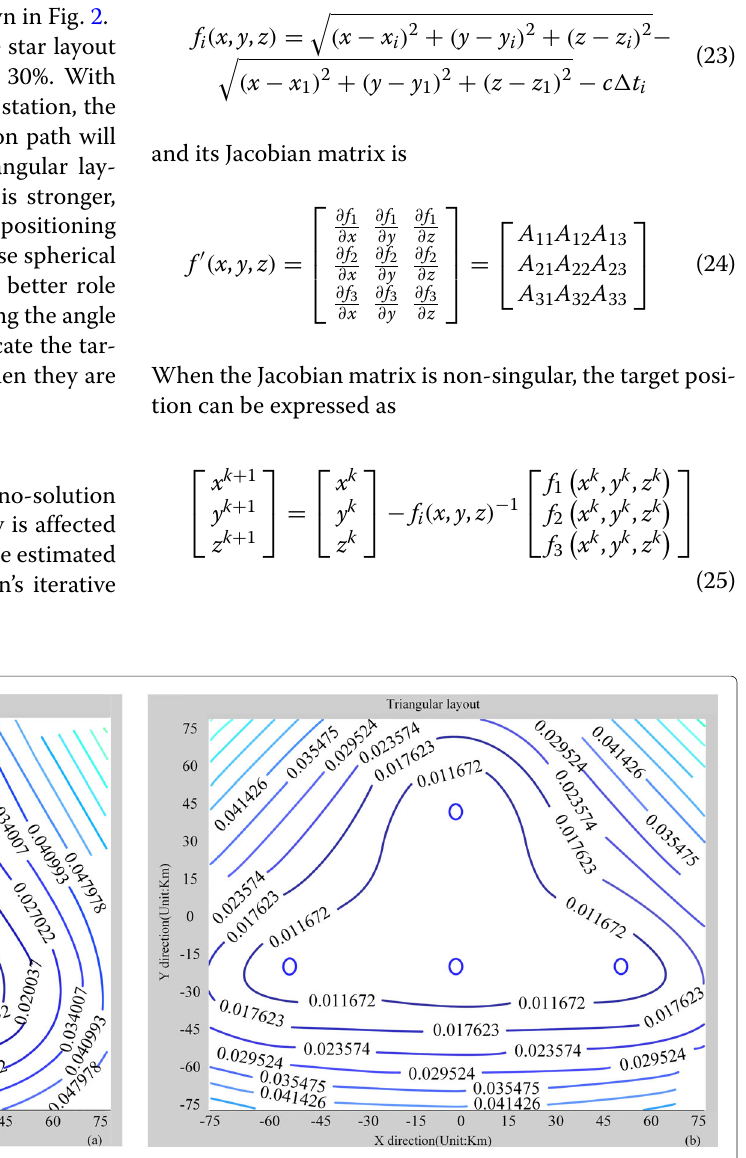
Fig. 2 Accuracy comparison. Accuracy comparison between star layout ( a ) and triangular layout ( b